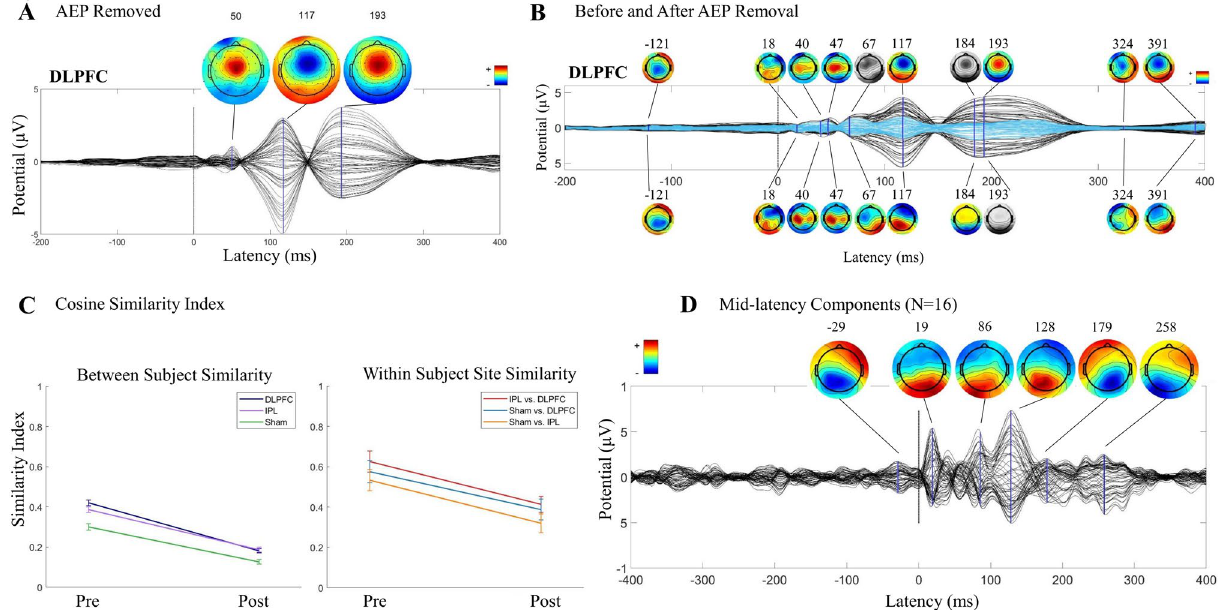
Figure 6. Validation using cohort of older adults (≥ 65 years) from SAGES study. 20 of the 24 participants have AEP components, regardless of the noise masking protocol, and this N = 20 is shown here. ( A ) AEP components removed, averaged across all participants (N = 20; DLPFC after being unmerged from other conditions). ( B ) DLPFC condition TEPs/topography pre (black/above) and post (blue/below) removal of AEP components. Topoplots are greyscale if no peak is present at the indicated latency. ( C ) Cosine similarity index average between-subject (left; calculated from half of the grid, excluding the diagonal) and within-subject site (right; calculated as the average of the diagonal of IPL/DLPFC, sham/DLPFC, and sham/IPL grids) pre and post removal of AEP components. ( D ) TEP/topography of all mid latency components contributing more than 28% variance in mid latency window in sham stimulation condition (N = 16) from full group